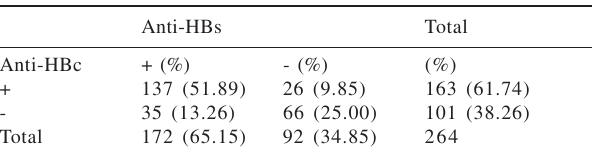
Table 2 - Correlation between Anti-HBc and Anti-HBs prevalence.